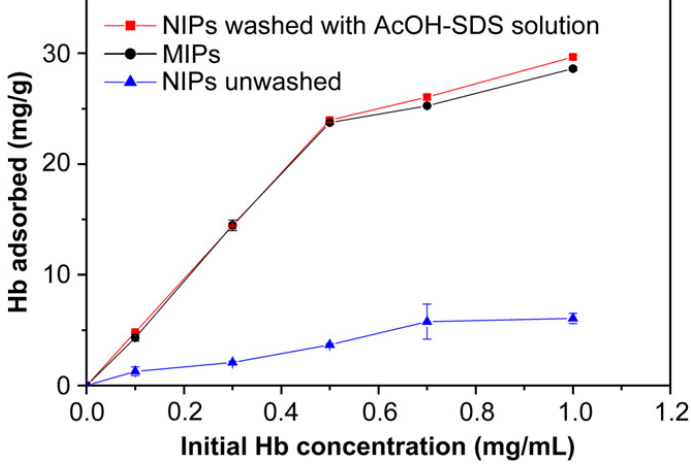
Figure 2. Hemoglobin (Hb) sorption isotherms on imprinted (MIP) and non-imprinted (NIP) polyacrylamide/chitosan semi-interpenetrated networks. The MIPs were washed with a 10% (v/v) AcOH solution containing 10% (w/v) sodium dodecylsulfate (SDS) to remove the template molecules, and then equilibrated in phosphate buffer pH 6.8. The Fu et al. [20] with permission from